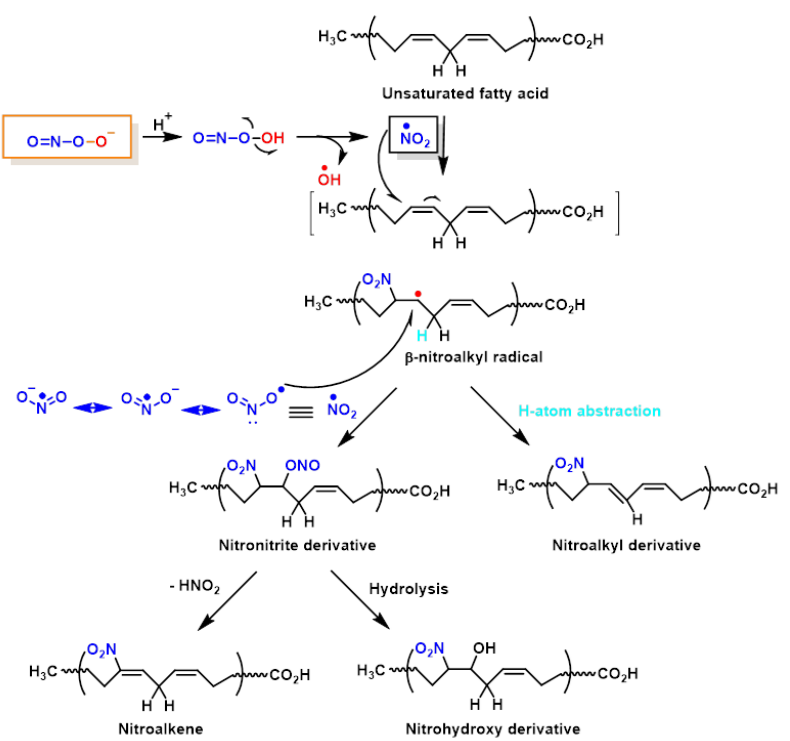
Figure 9. Lipid oxidation and nitration to nitrohydroxyderivatives.